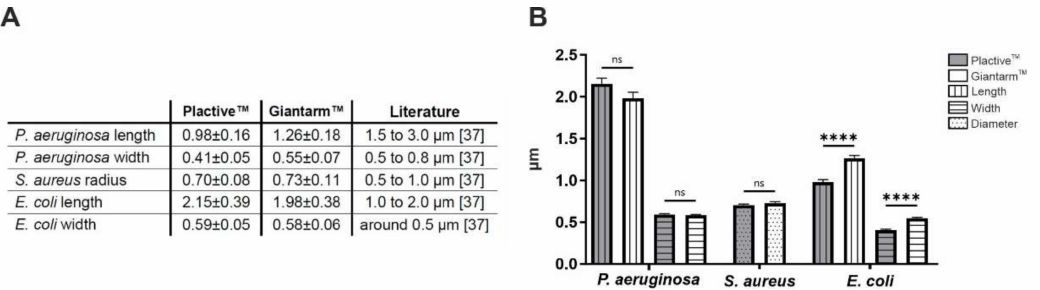
Figure 7. Comparison of the measured and literature size values and mean of the measured size values depicted in a bar graph ( A ) Table showing the measured values and literature values of the three analyzed bacteria ( P. aeruginosa , S. aureus , E. coli ) [37]. The second and third columns depict the measured values on Plactive™ PLA and Giantarm™ PLA, respectively. The fourth column shows the literature value. ( B ) Bar graph depicting the mean of the measured size values in microns for the three different bacteria. The first group belongs to P. aeruginosa , of which the two longer bars show the length of the bacteria on Plactive™ PLA and Giantarm™ PLA, respectively. The two shorter bars visualize the width of the bacteria, the first of the two on Plactive™ PLA and the second on Giantarm™ PLA. The group of two bars in the middle of the graph belongs to S. aureus , where the mean of the diameter is visualized, the left bar showing the value on Plactive™ PLA and the right bar the value on Giantarm™ PLA. The four rightmost bars belong to E. coli , where the two left bars of the group depict the mean of the length of the bacteria on Plactive™ PLA and Giantarm™ PLA, respectively. The two right bars show the mean of the width of the bacteria on Plactive™ PLA and Giantarm™